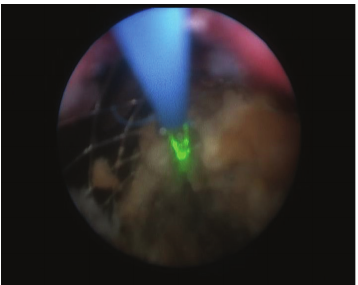
Figure 2: Right-sided nephrotomography shows complete obstruc- tion at the encrusted nitinol mesh stent.